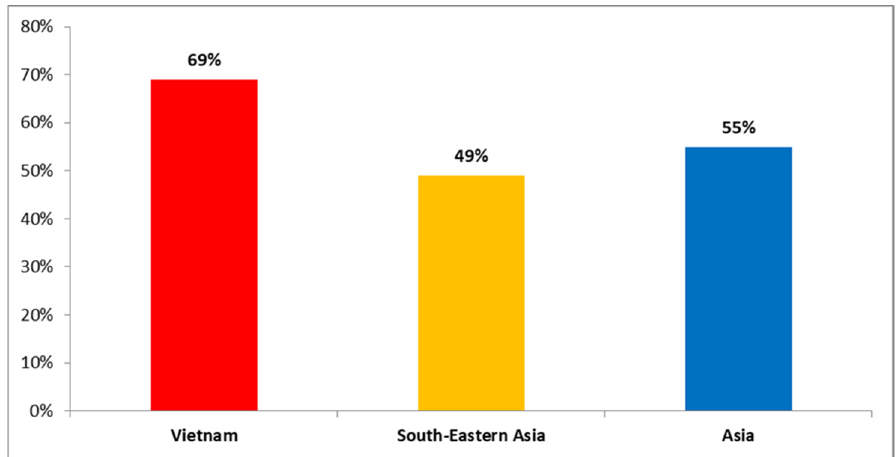
Figure 1. Unbanked population in Vietnam and Asia regions. Source: (World Bank 2017).